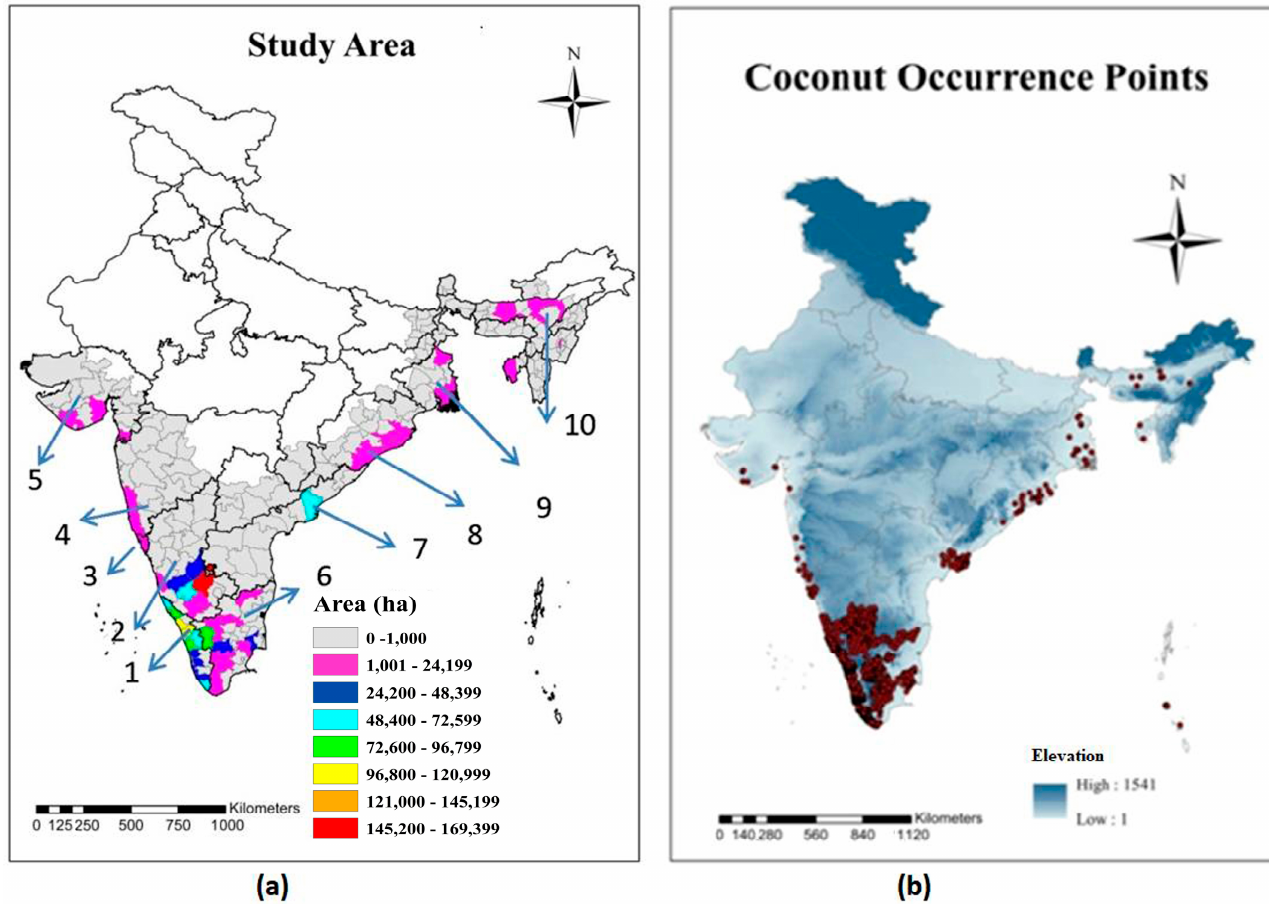
Figure 1. ( a ) Map showing the spatial distribution of coconut in different regions of India. State- wise and district-wise area data 2018-19 obtained from https://coconutboard.nic.in/Statistics.aspx, accessed on 7 January 2021 Numbers on the map show the coconut growing states viz. Kerala (1), Karnataka (2), Goa (3), Maharashtra (4), Gujarat (5), Tamil Nadu (6), Andhra Pradesh (7), Odisha (8), West Bengal (9), and Assam (10); and ( b ) the red point indicates the coconut occurrence points used in model